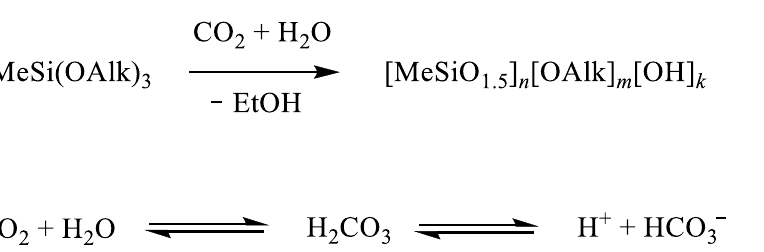
Figure 6. Scheme of hydrolytic polycondensation of methyltrialkoxysilane in the presence of car- bonic acid. Adopted from Ref. [53]. acid. Adopted from Ref.